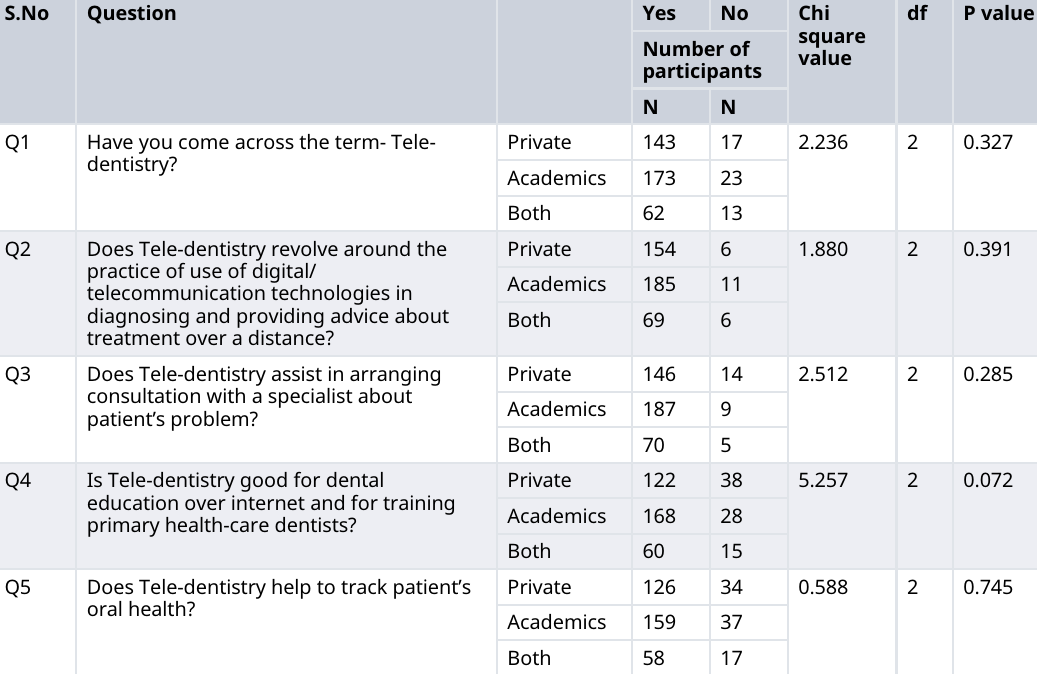
Table 3. Type of dental practice and response regarding teledentistry.